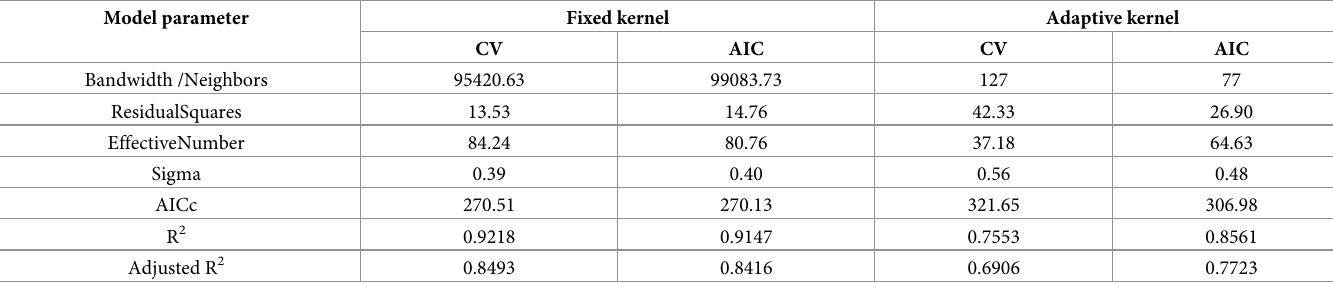
Table 5. GWR model bandwidth calculation results.